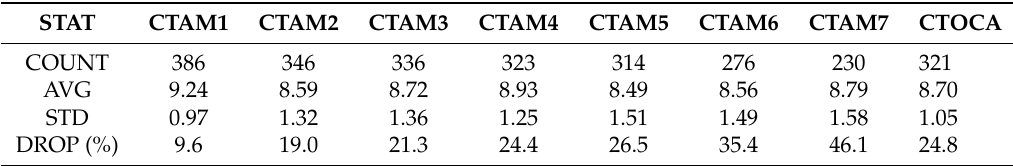
Table 1. Statistical overview of the students’ results for the theoretical activities across three academic years ( N =